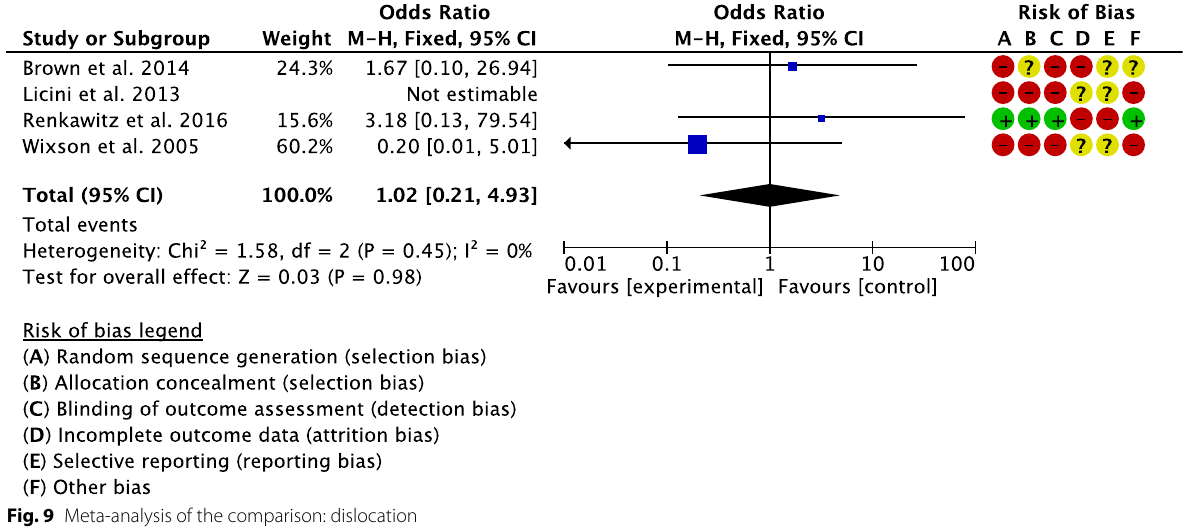
length discrepancy but longer duration of the surgi- cal intervention. Cup positioning, Harris Hip Score and dislocation rates were similar between the two interventions.